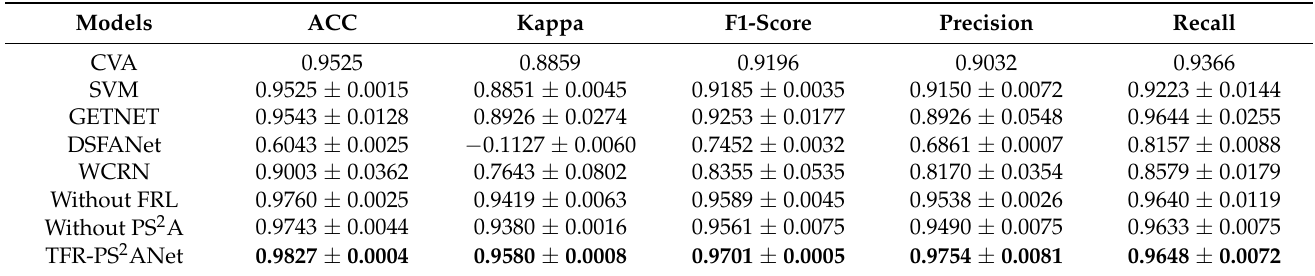
Table 3. Model comparison results and module ablation study results on the Wetland Agriculture Dataset (repeated 3